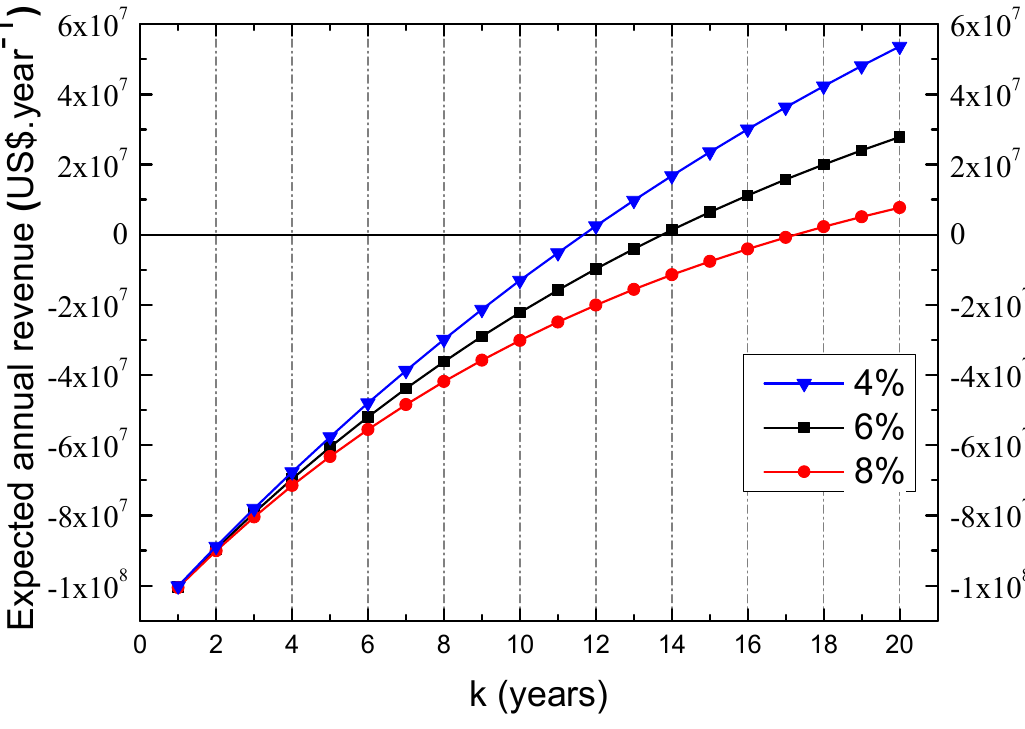
Figure 3. Annual revenue expected with WIG-GTCC for different annual interest rates .